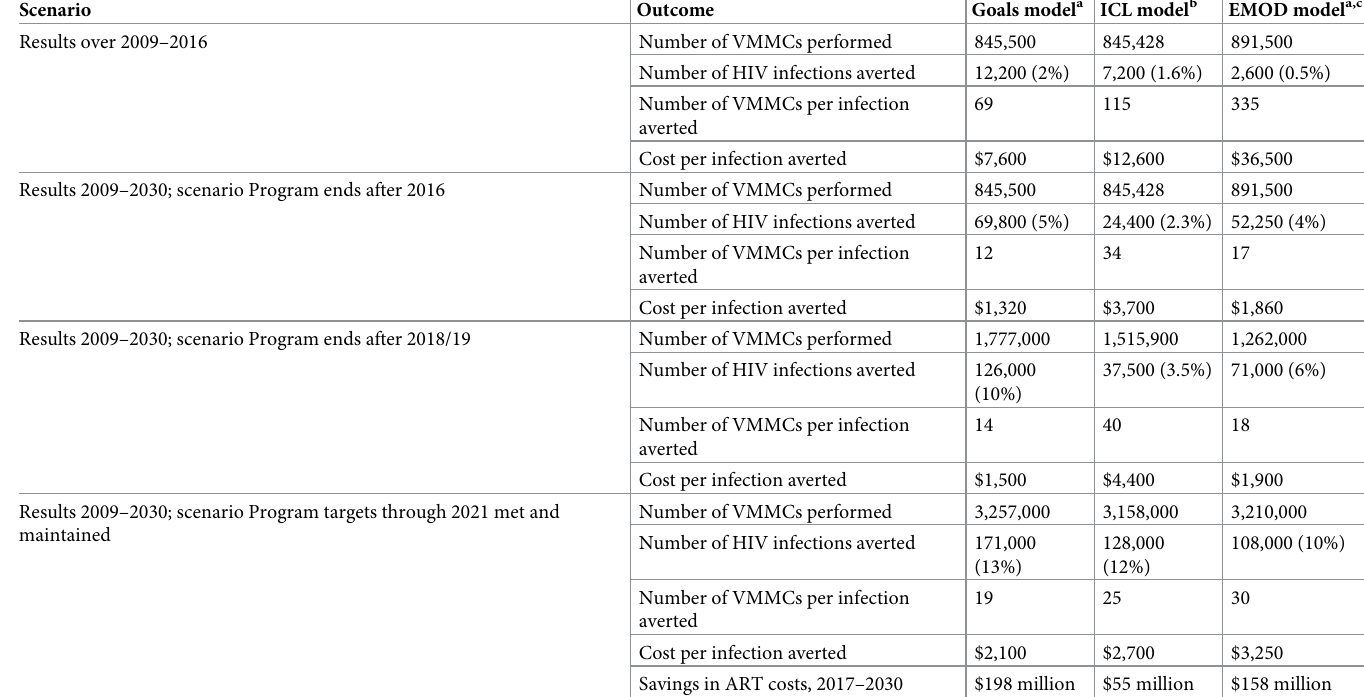
Table 2. Projected impact, costs and savings from the VMMC program in a ’status quo’ background context, relative to the counterfactual scenario of no VMMC program ever.